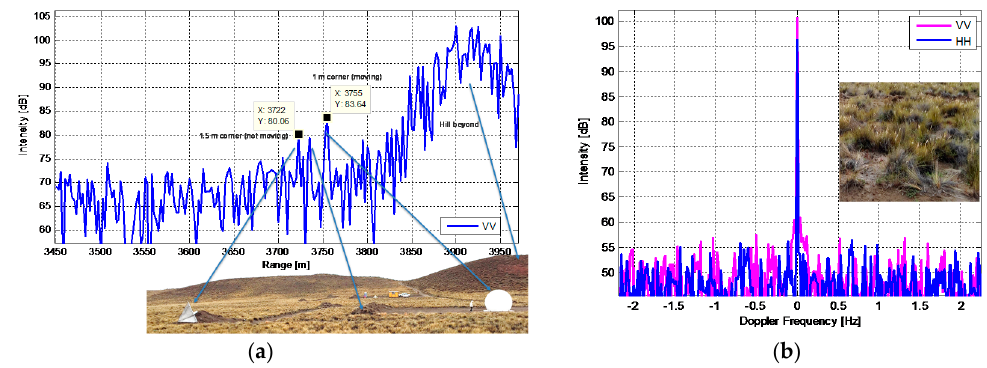
Figure 5. ( a ) Range-compressed data intensity profile and interpretation; ( b ) Doppler analysis of the clutter.